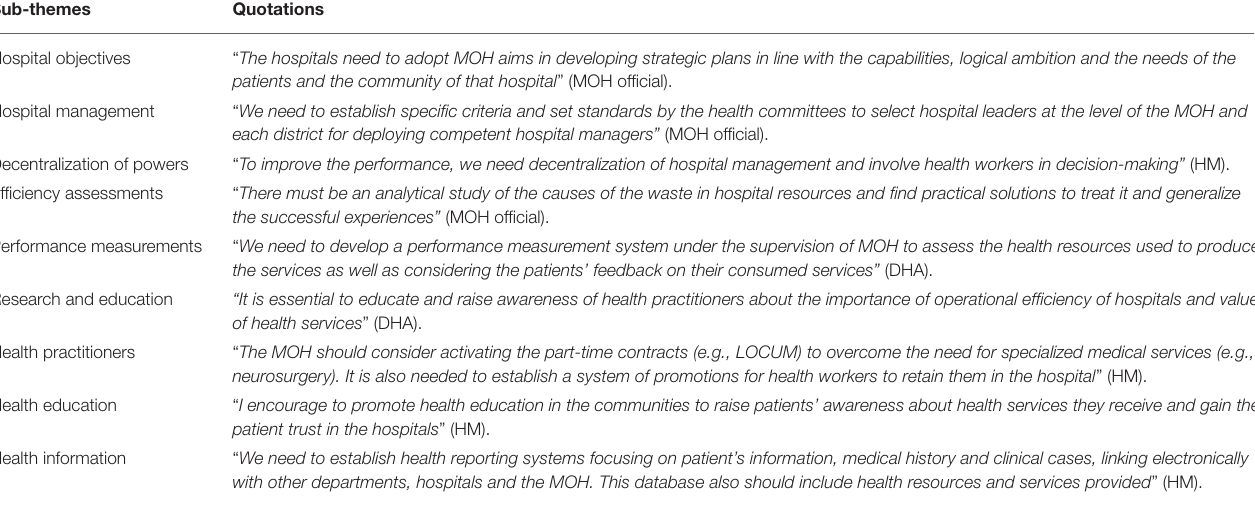
TABLE 3 | Feasible options to improve the efficiency in the public